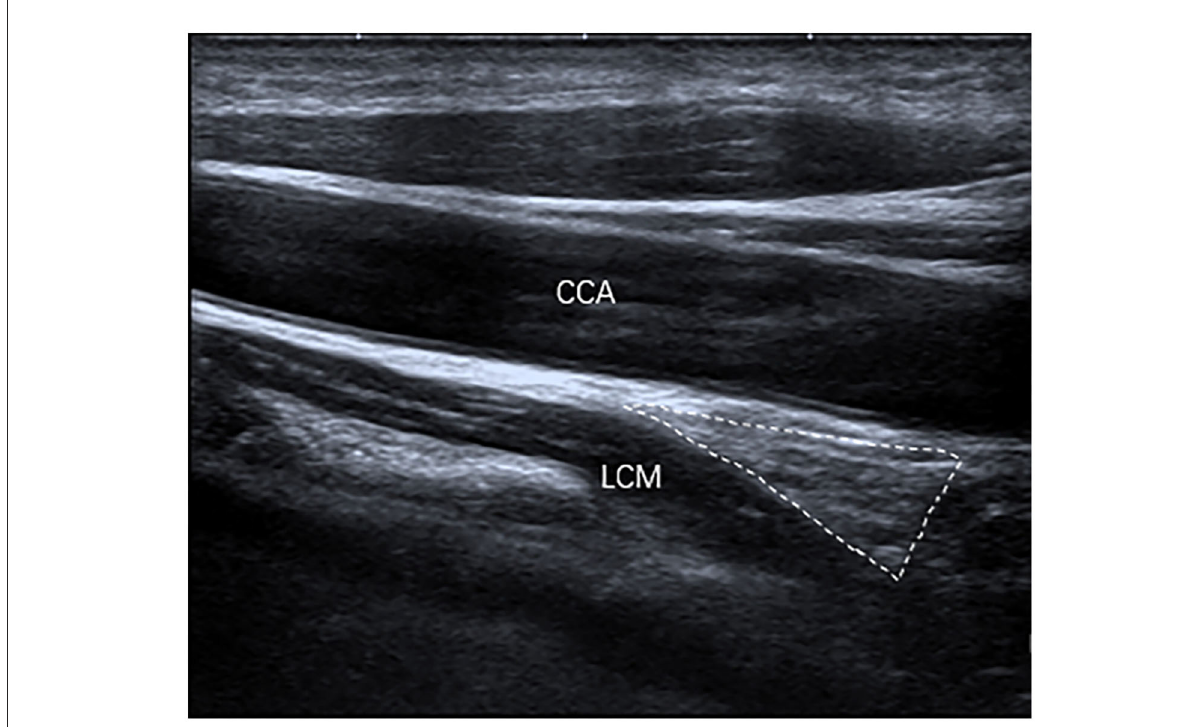
FIGURE3 The SG, with a triangular shape (outlined) and hyperechogenicity, was located between the common carotid artery (CCA) and the longus colli muscle (LCM) on the longitudinal ultrasound image.